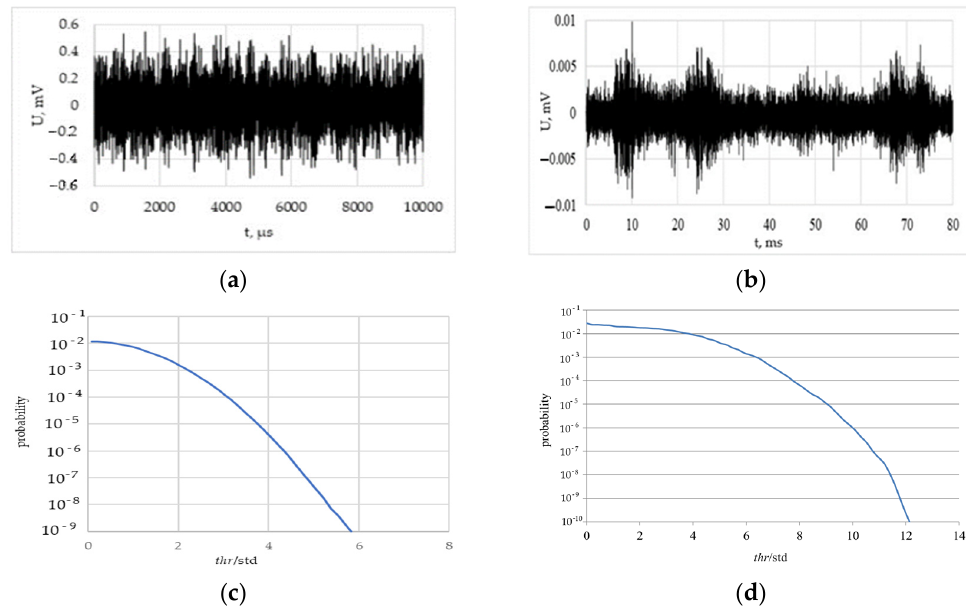
Figure 15. Temporal realizations ( a , b ) and probability density functions ( c , d ) of noise caused by compressor ( a , c ) and turbulent fluid flow ( b , d ).